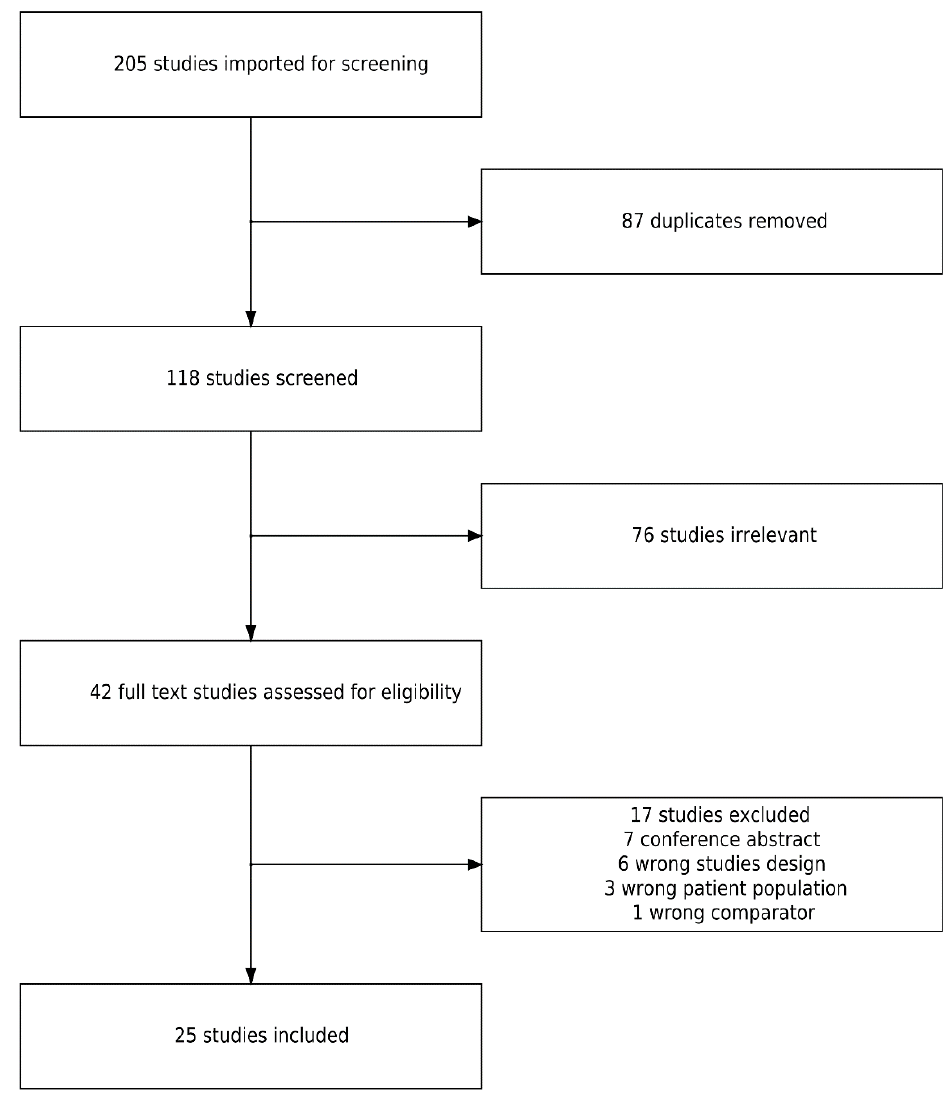
Figure 1. Flow chart of the selection process.